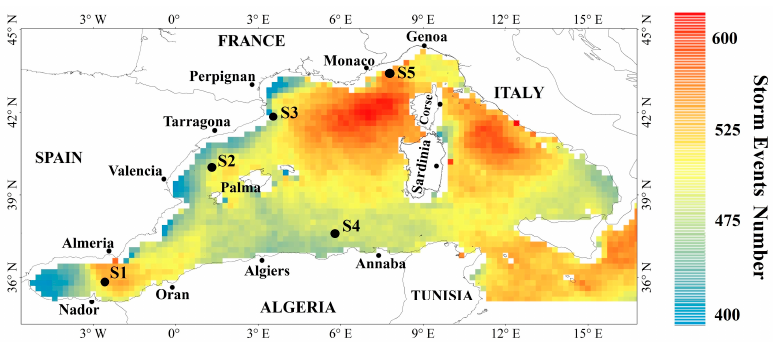
Figure 3. Map showing the number of storm wave events occurring at each analyzed point during the period of 1979 to 2019.